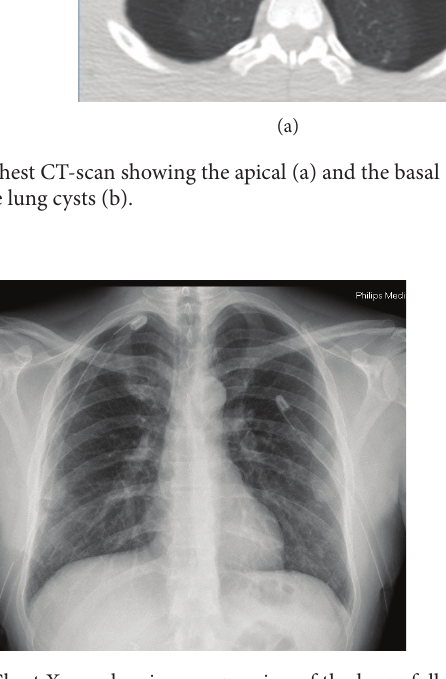
Figure 2: Chest X-ray showing reexpansion of the lungs following bilateral chest tube insertion.